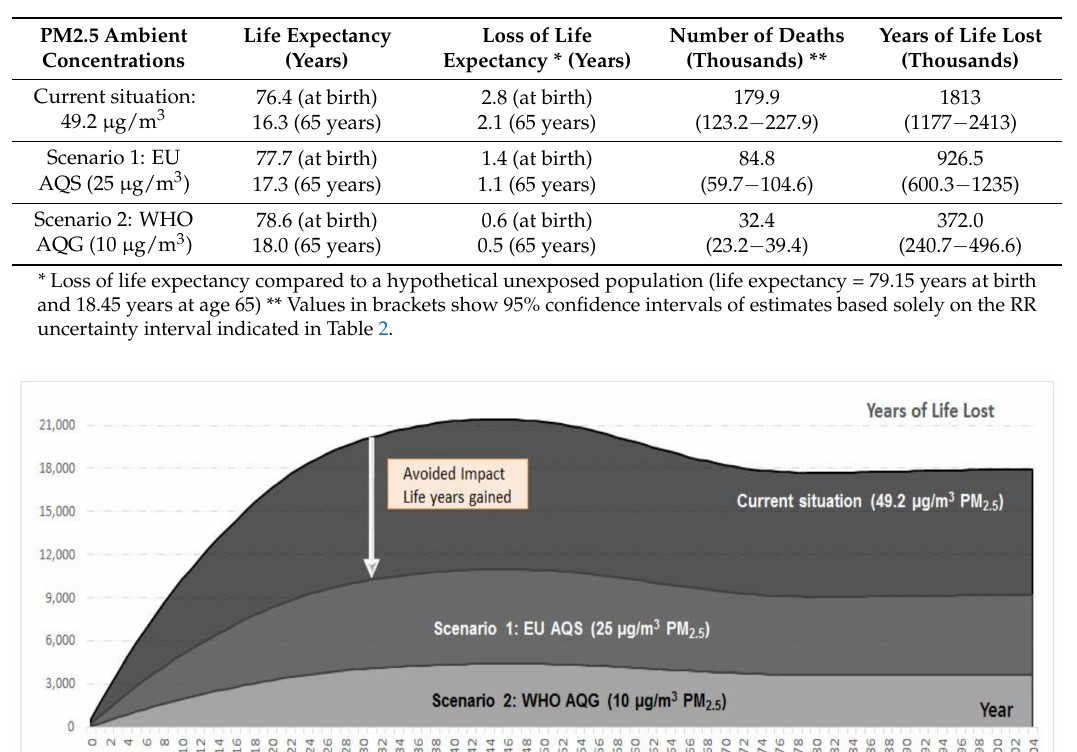
Table 3. Health burdens of the different PM 2.5 scenarios, expressed as aggregate impact over a follow-up period of 105 years.